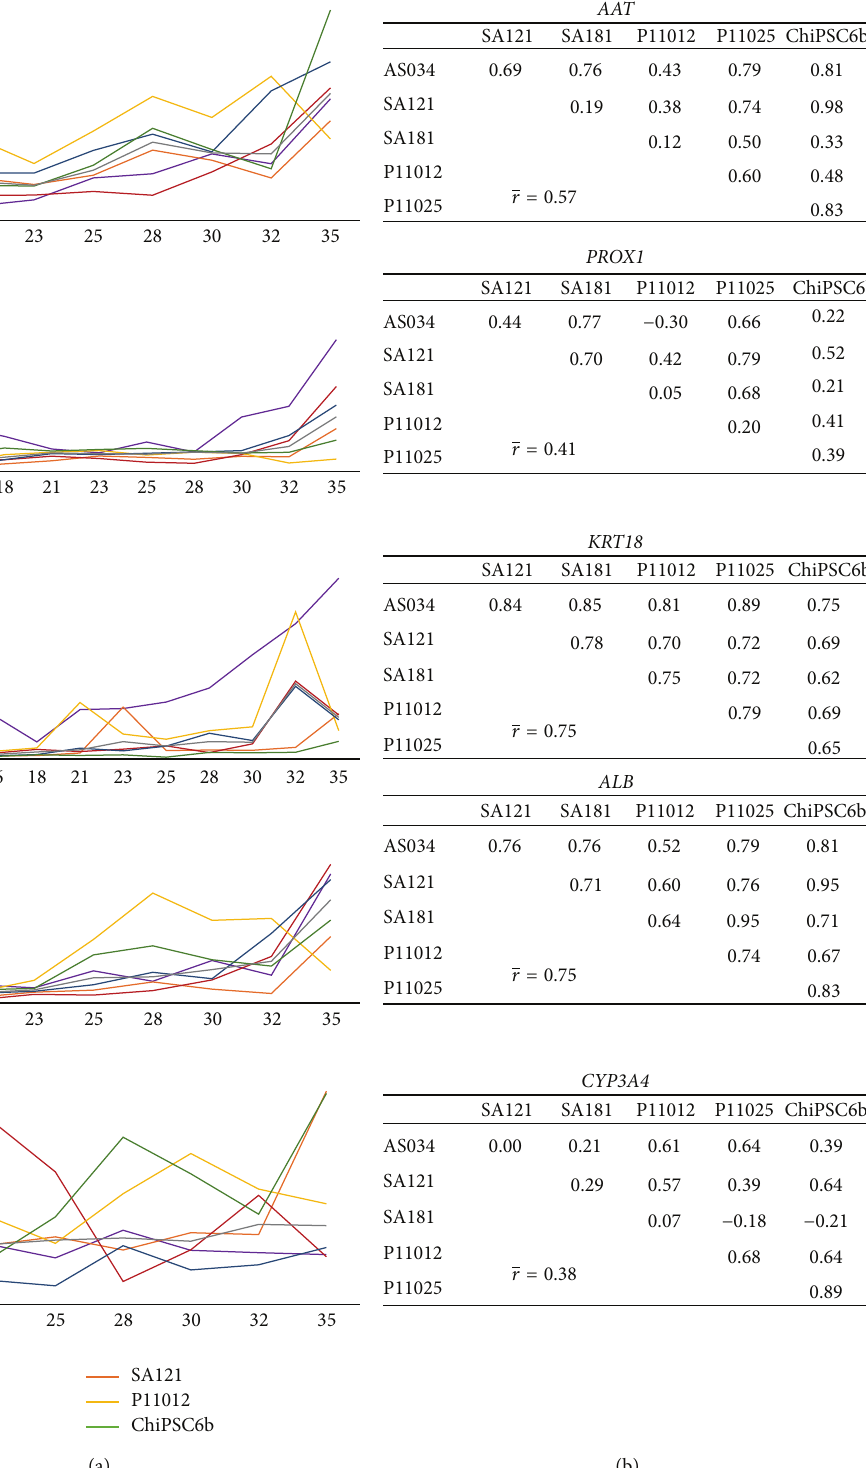
Figure 7: Gene expression profiles of later hepatic markers ( AAT , PROX1 , KRT18 , ALB , and CYP3A4 ) in the interval from day 13 to day 35. (a) The 𝑥 -axis indicates the days during differentiation and the 𝑦 -axis indicates RQ, where the calibrator’s RQ = 1. The colored lines show the results from each individual hPSC line and the grey line indicates the calculated median value of the RNA level. Correlation tables are shown in (b). The graphs show synchronicity of onset and up- and downregulation among all cell lines for the genes AAT , PROX1 , KRT18 , ALB , and CYP3A4 . The average correlation between pairs of cell lines ranges from weak (0.38 for CYP3A4 ) to strong (0.75 for KRT18 and ALB